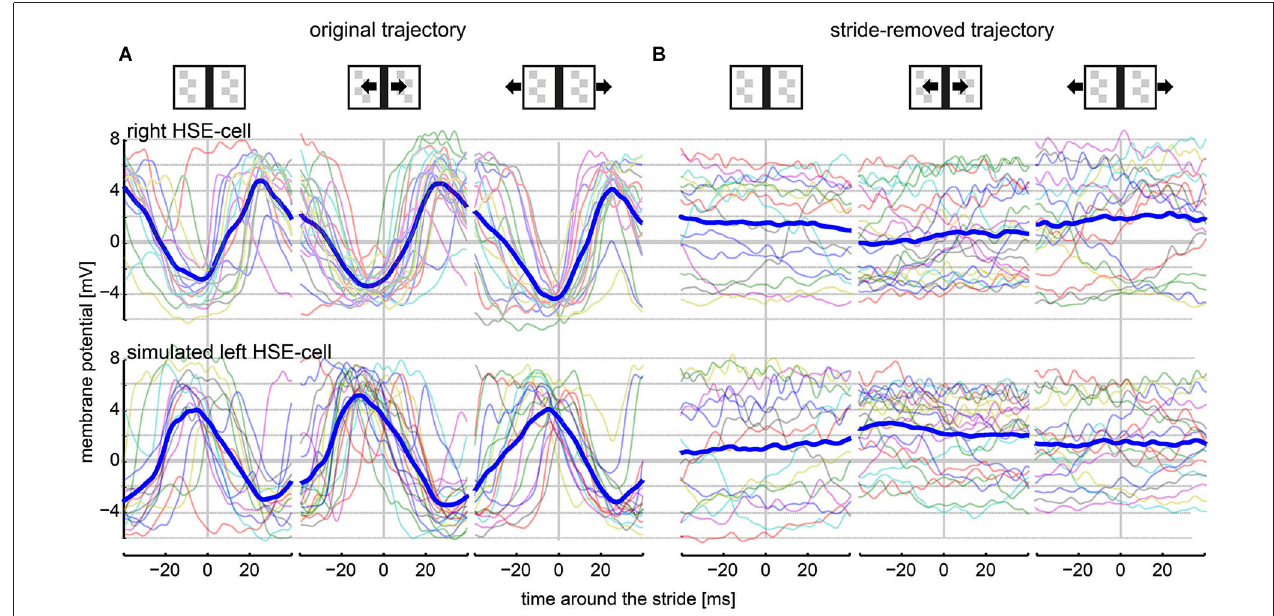
with the original movie. Average responses (thick, dark blue lines) are shown together with the respective individual stride-coupled responses (semi-transparent, colored lines). (B) HSE responses within the stride cycle when stimulated with the stride-removed movie. Analyzed amount of strides: stationary condition: 15 strides; moving bar condition: 22 strides; moving background condition: 17